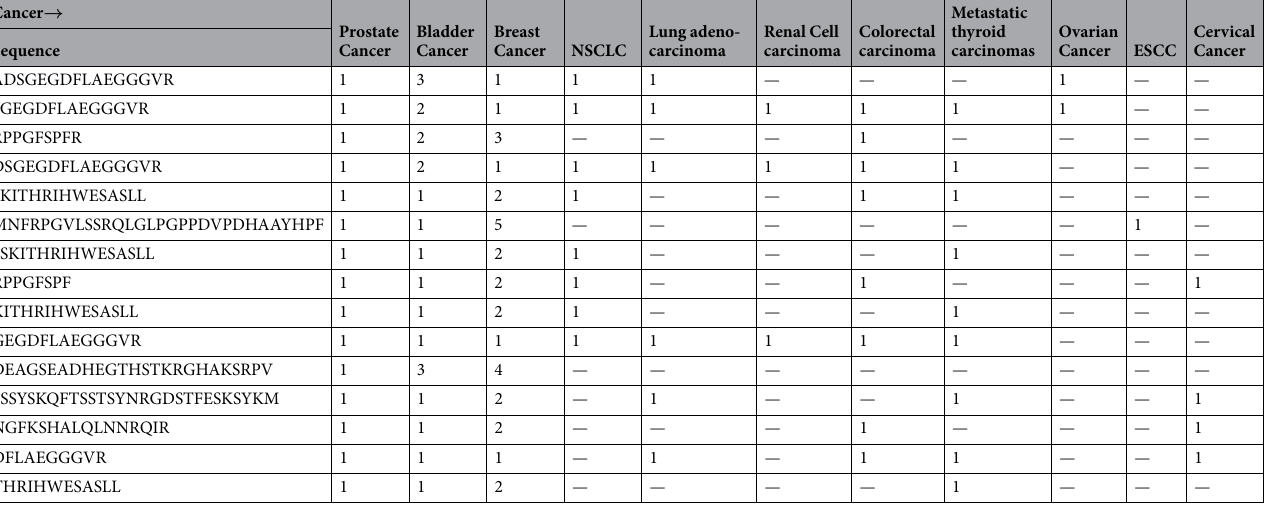
Table 3. Top fifteen unique peptides associated with different cancers. Each number in the cell represents the number of studies associated with each